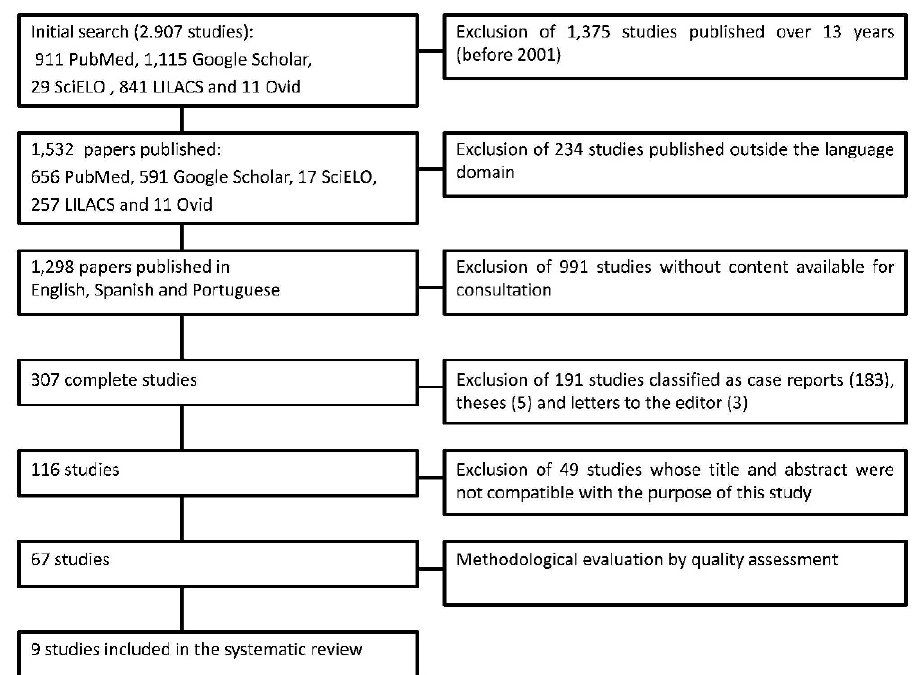
Figure 1 - Outline of the steps for the selection of the studies.